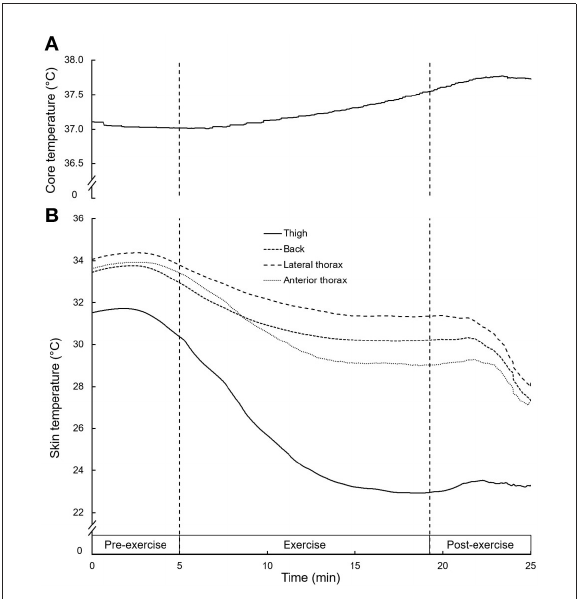
FIGURE2 Mean core (A) and skin (B) temperature at different body parts before, during and after exercise. Dashed lines mark the start and end of the skiing